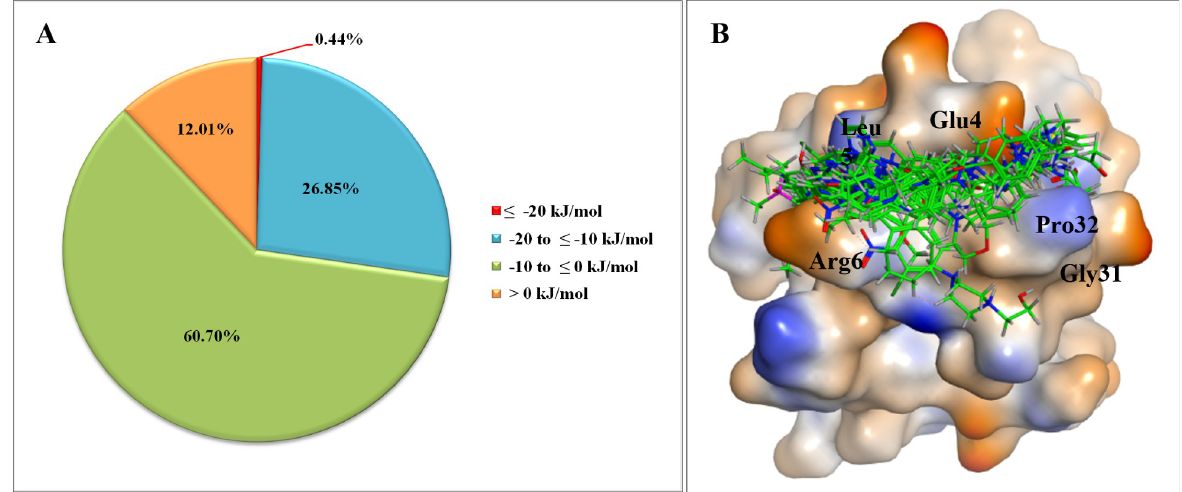
Fig 3. Results of molecular docking. (A) Percentage of docked ligands into the binding pocket of IL-8 according to the score range. (B) The top 23 hit compounds (carbon atoms in green) in the binding pocket.